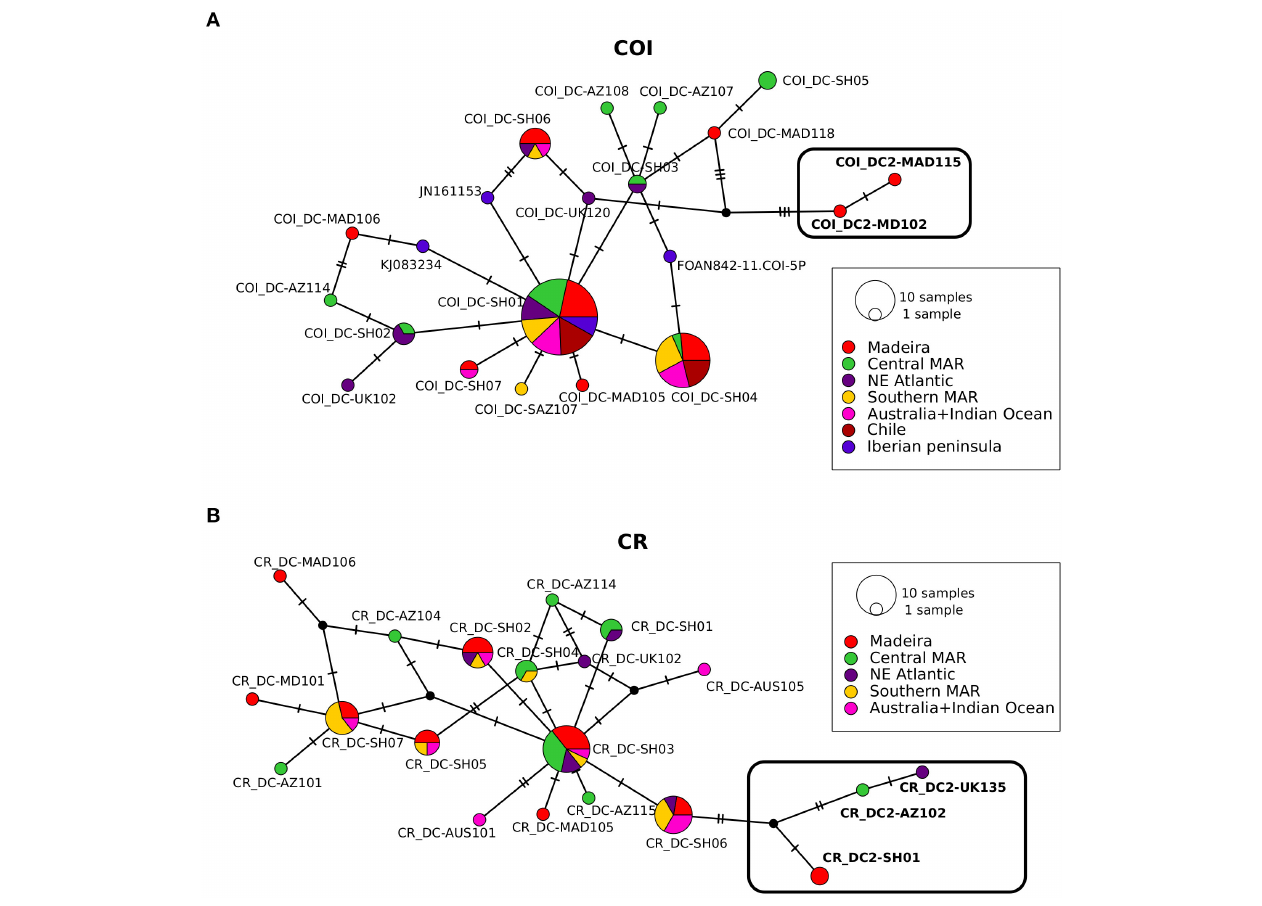
FIGURE 4 | Integer neighbour-joining haplotype networks for COI (A) and CR (B) . Circles represent haplotypes and size is proportional to the relative frequencies. Colours are associated to sampling localities and the numbers of substitutions are indicated with bars when more than one. Haplotype coding is given in Supplementary Table S1